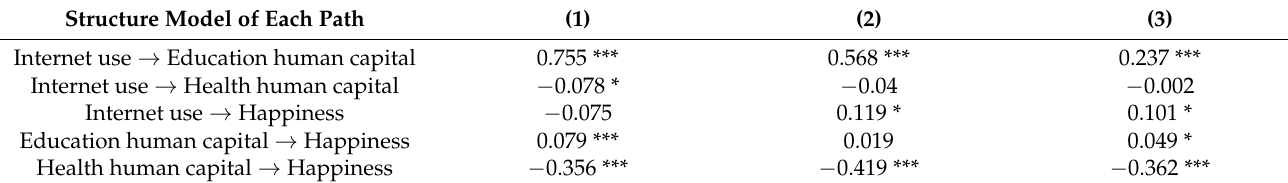
Table 6. Heterogeneity analysis by family structure.